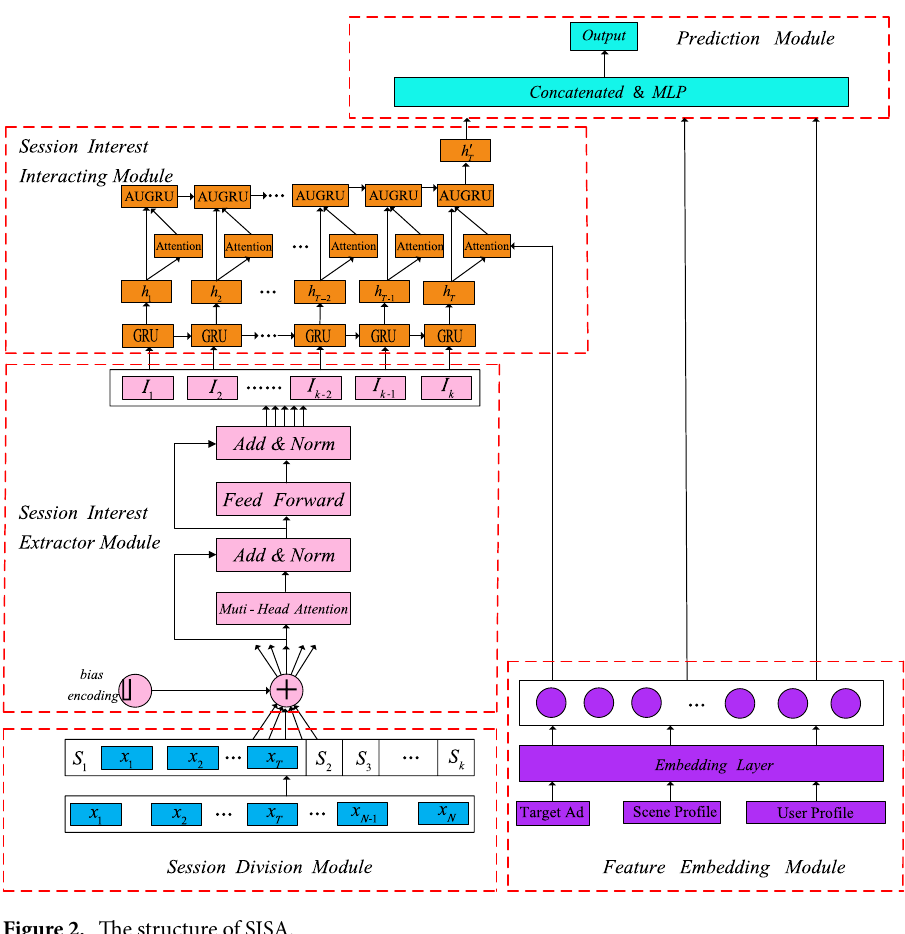
Figure 2. The structure of